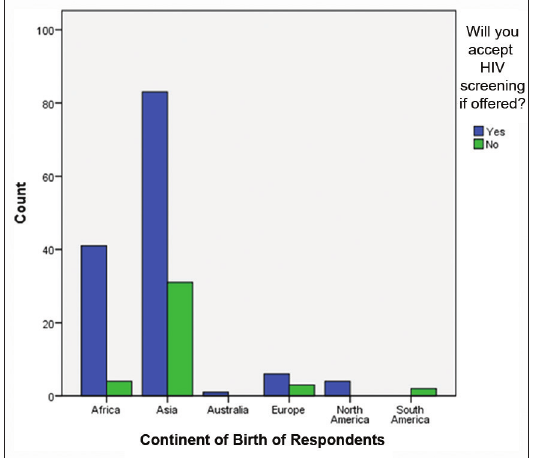
Figure 3: Acceptance of HIV screening and continent of origin of the